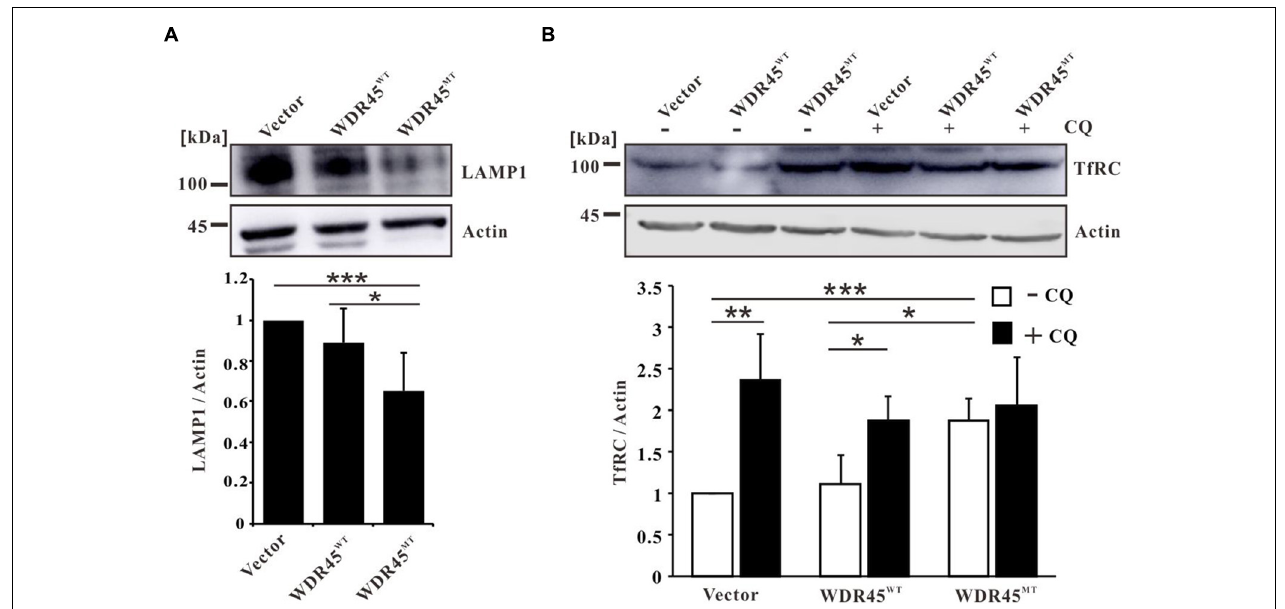
FIGURE 1 | Transferrin receptor (TfRC) was accumulated in WDR45-deficient cells. (A) The lysosomal protein LAMP1 was significantly lowered in WDR45 MT expressing HeLa cells. (B) TfRC was accumulated in WDR45 MT expressing HeLa cells and in WDR45 WT expressing HeLa cells treatment with 100 µ M autophagy inhibitor chloroquine (CQ) for 8 h. * p < 0.05; ** p < 0.01; *** p < 0.001.